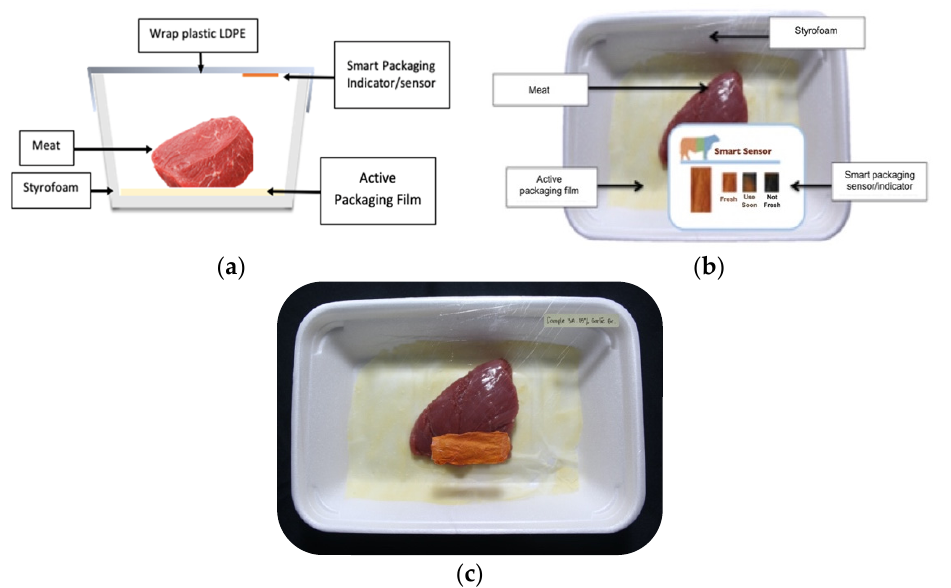
Figure 1. ( a ) Design of the intelligent and active packaging system; ( b ) prototype of the intelligent packaging; ( c ) and its application on fresh beef.